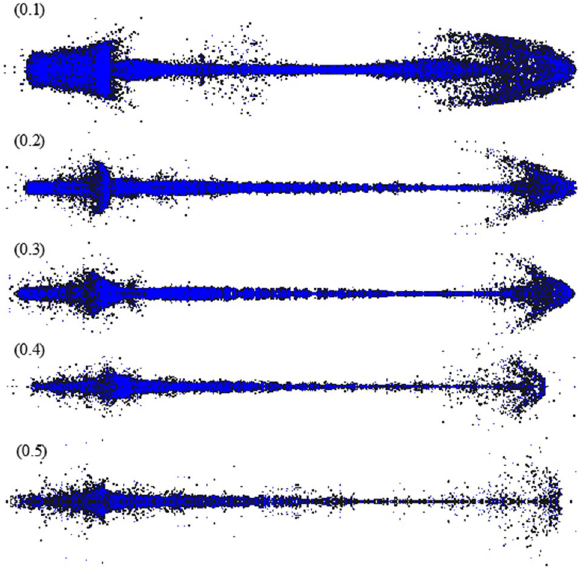
Figure 11. Jet shape of the different particle sizes (60 μs).